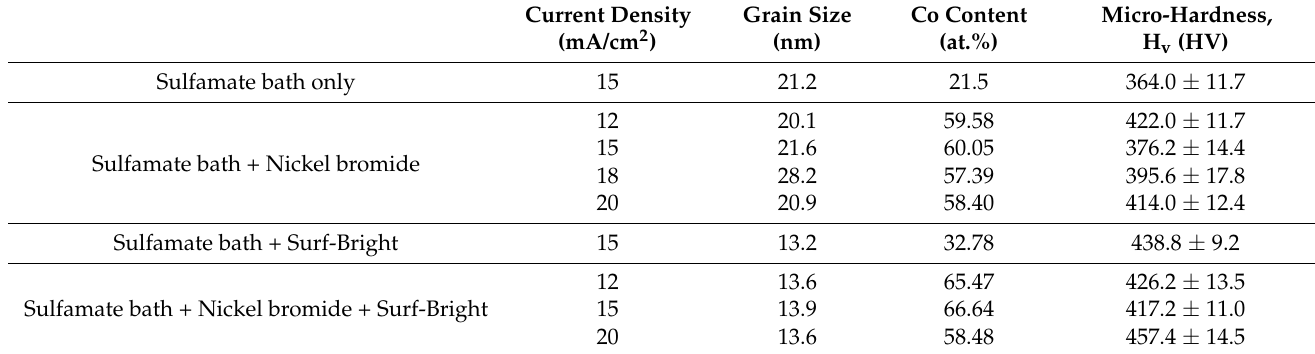
Table 1. Effects of the current density on the average grain size, cobalt content, and